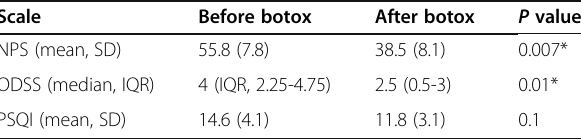
Table 2 NPS, ODSS, PSQI before and after botox